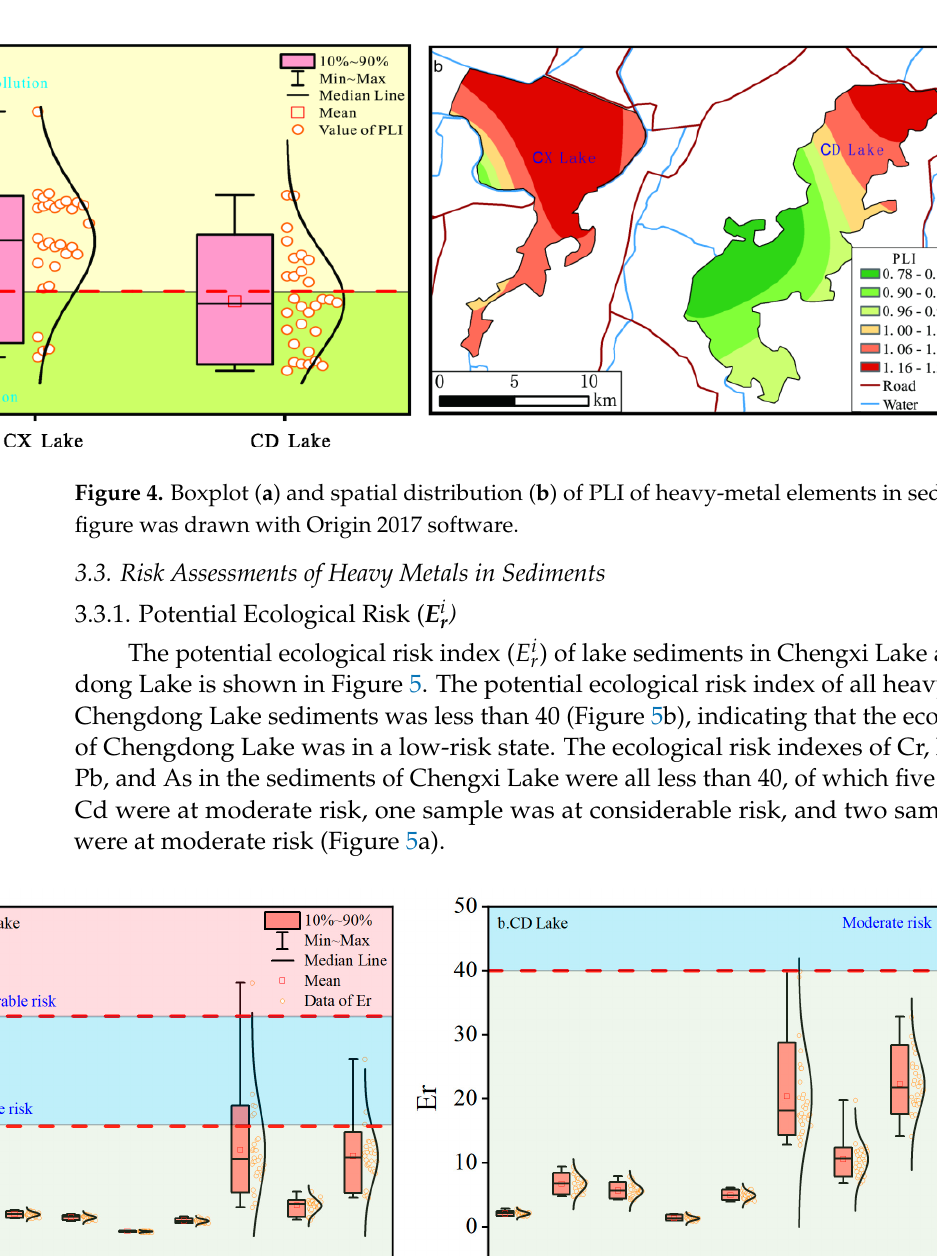
Figure 4. Boxplot ( a ) and spatial distribution ( b ) of PLI of heavy-metal elements in sediment. This figure was drawn with Origin 2017 software.